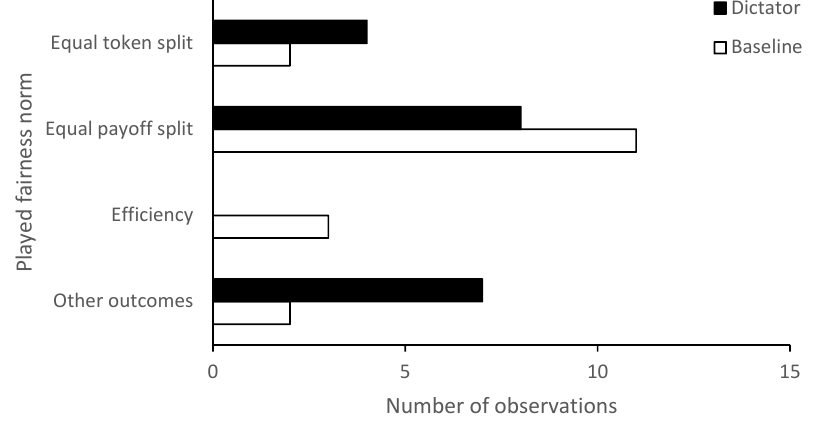
Figure 1. Observed frequency of experimental fairness norms.